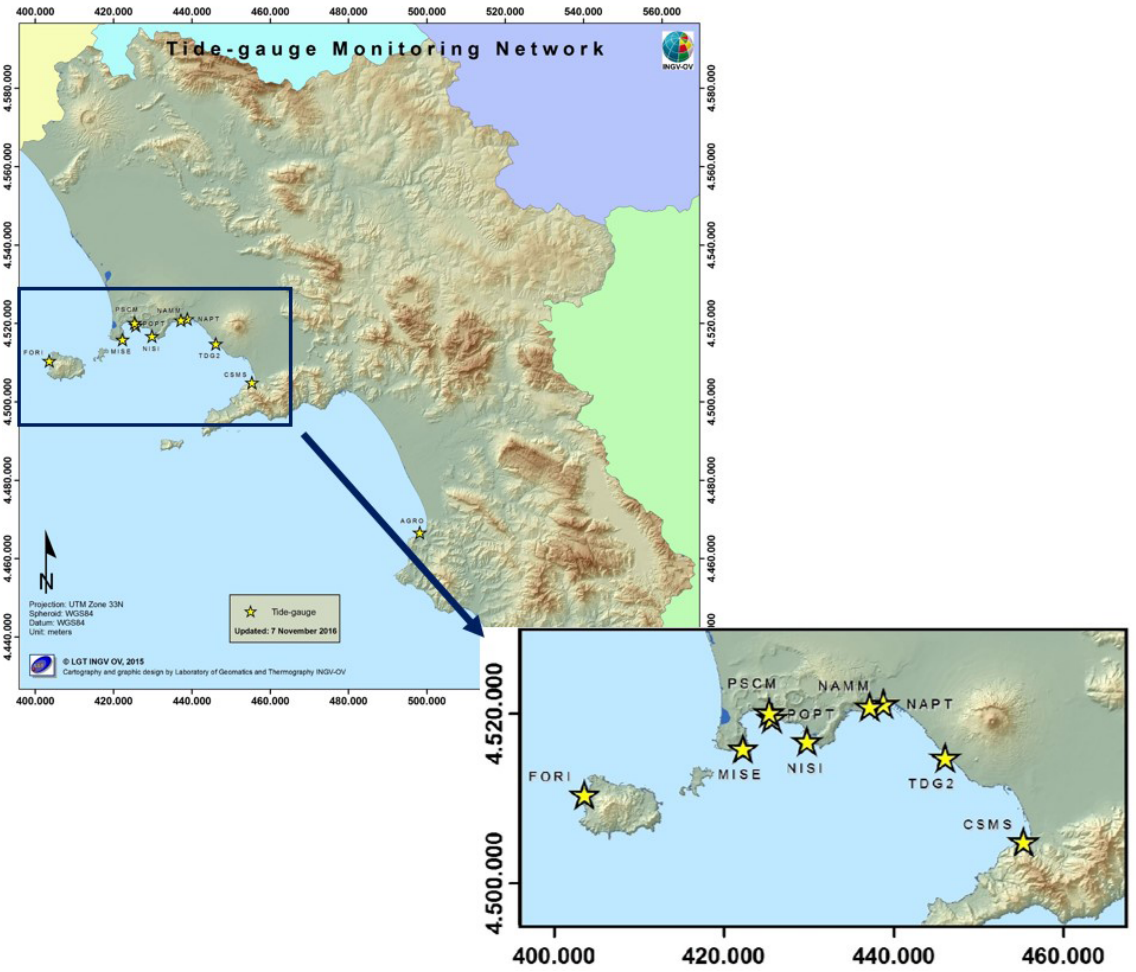
Figure 1. Neapolitan Tide Gauge Network (NTGN) managed by Osservatorio Vesuviano, branch of INGV. For clarity, we do not show the GNNS station called RITE, because it is very close to POPT tide gauge. The map was created by the INGV-OV Laboratory of Geomatics and Thermography, © LGT INGV OV,